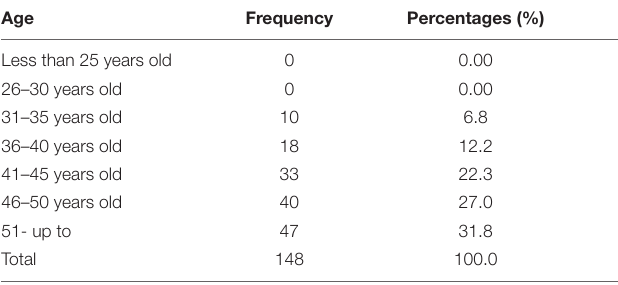
TABLE 3 | Age of the respondents.